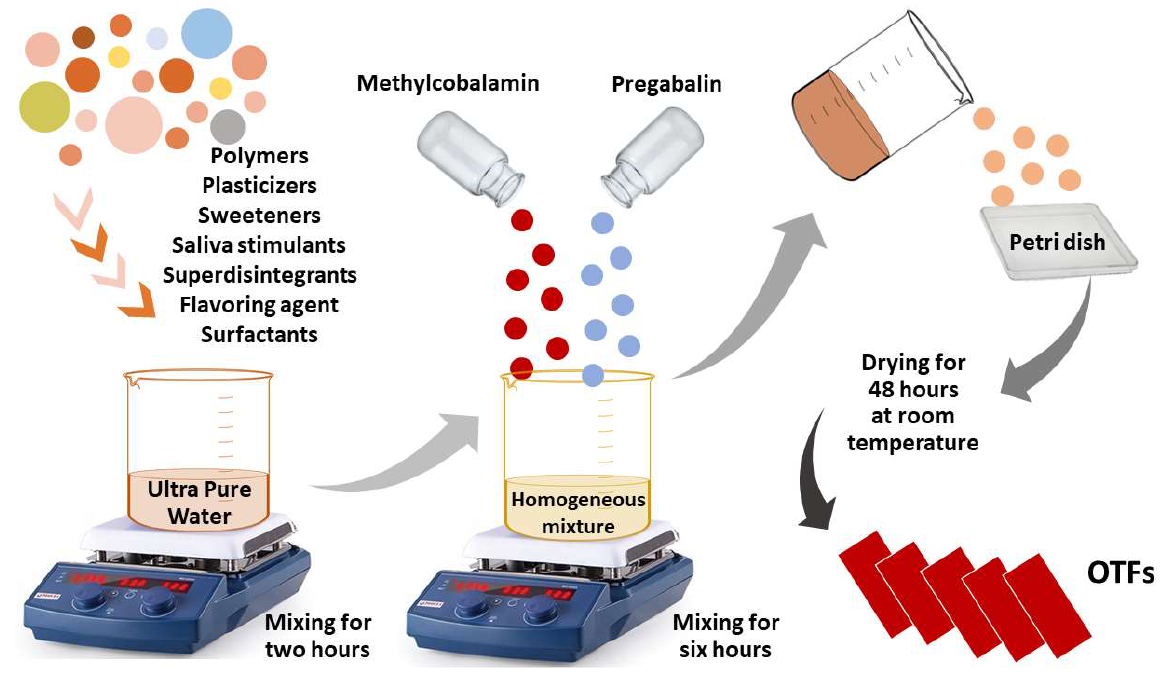
Figure 10. Preparation of OTFs